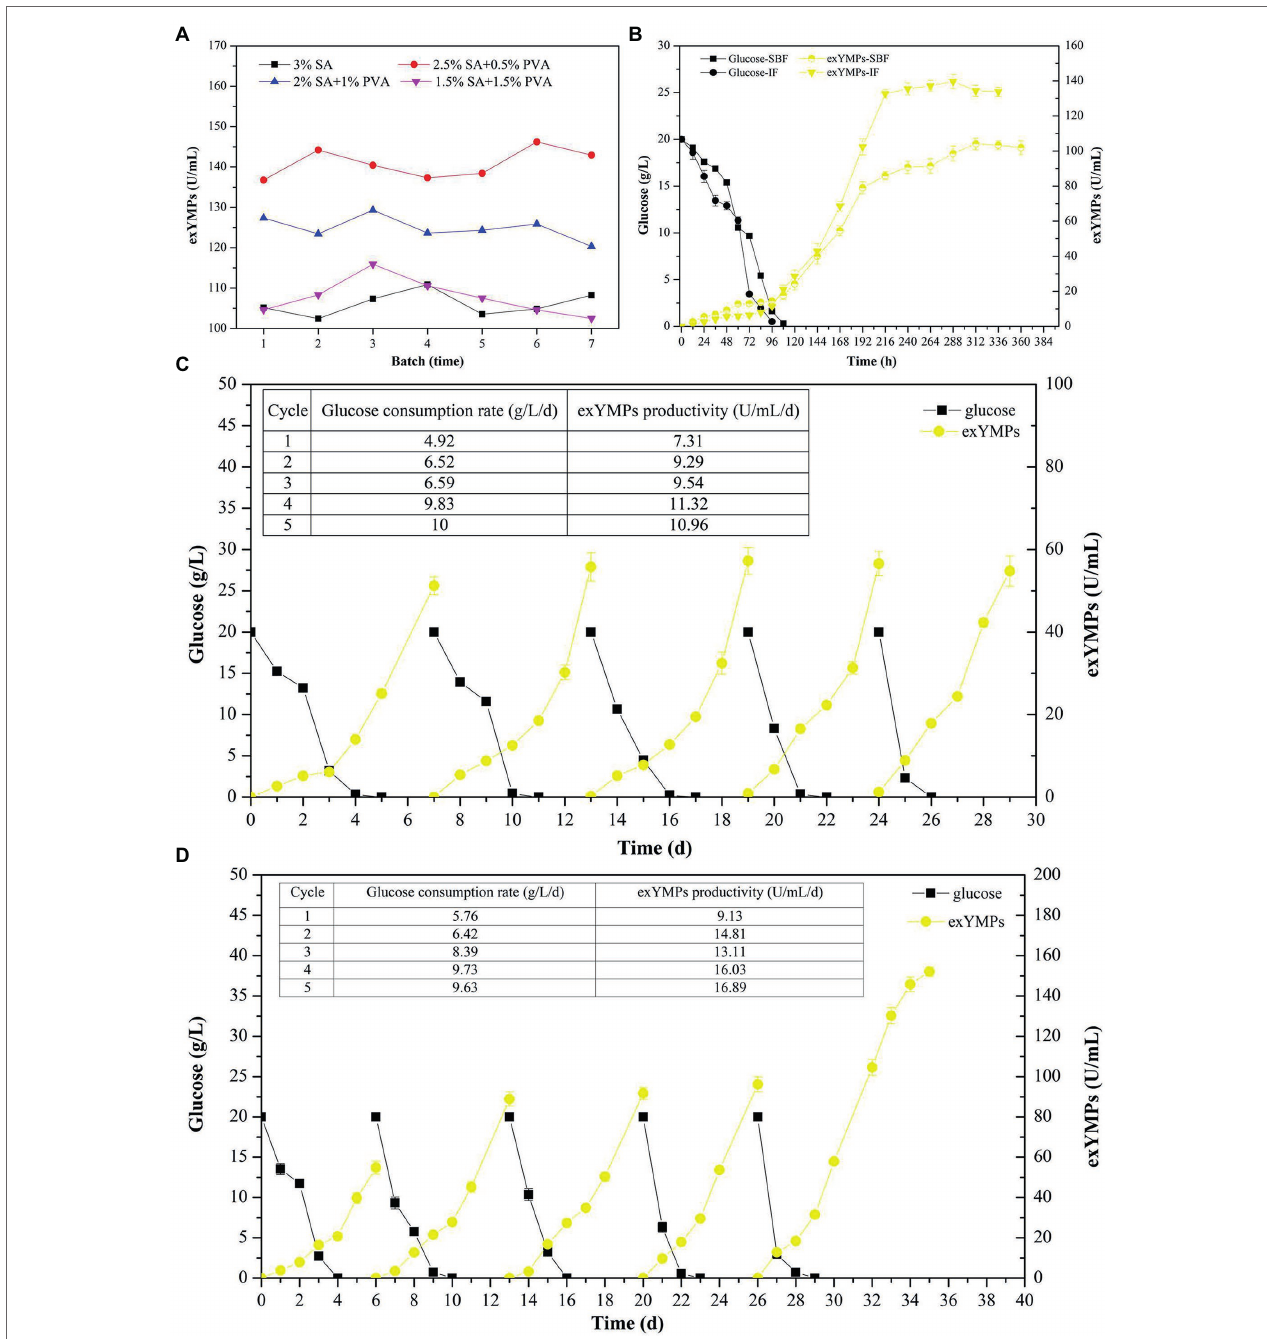
FIGURE 4 | The effect of different ratios of sodium alginate and polyvinyl alcohol solution on the production of extracellular yellow monascus pigments via repeated batch fermentation of M. purpureus H14 (A) ; glucose consumption and the biosynthesis of extracellular yellow monascus pigments of M. purpureus H14 during conventional SBF and immobilized fermentation (B) ; glucose consumption and the biosynthesis of extracellular yellow monascus pigments of M. purpureus H14 during repeated-batch fermentation without (C) and with (D) Triton X-100